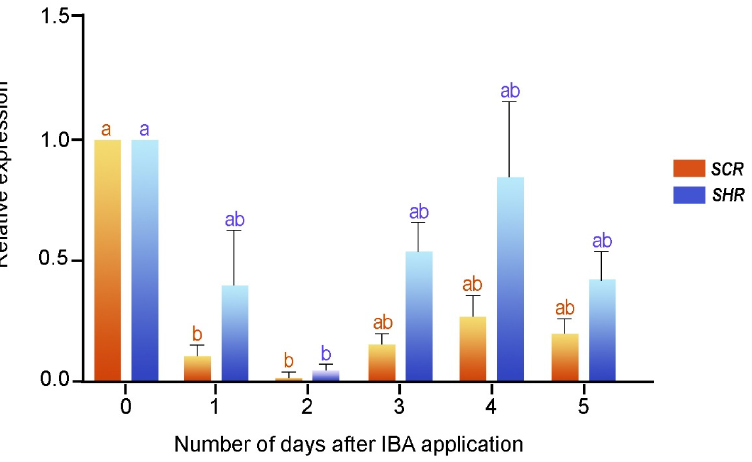
Figure 3. SCR and SHR gene expressions during the early step of adventitious root formation in two-month-old microshoots. Each column denotes the means of three replicates ± SEM Significant differences ( p < 0.05) are marked using lowercase